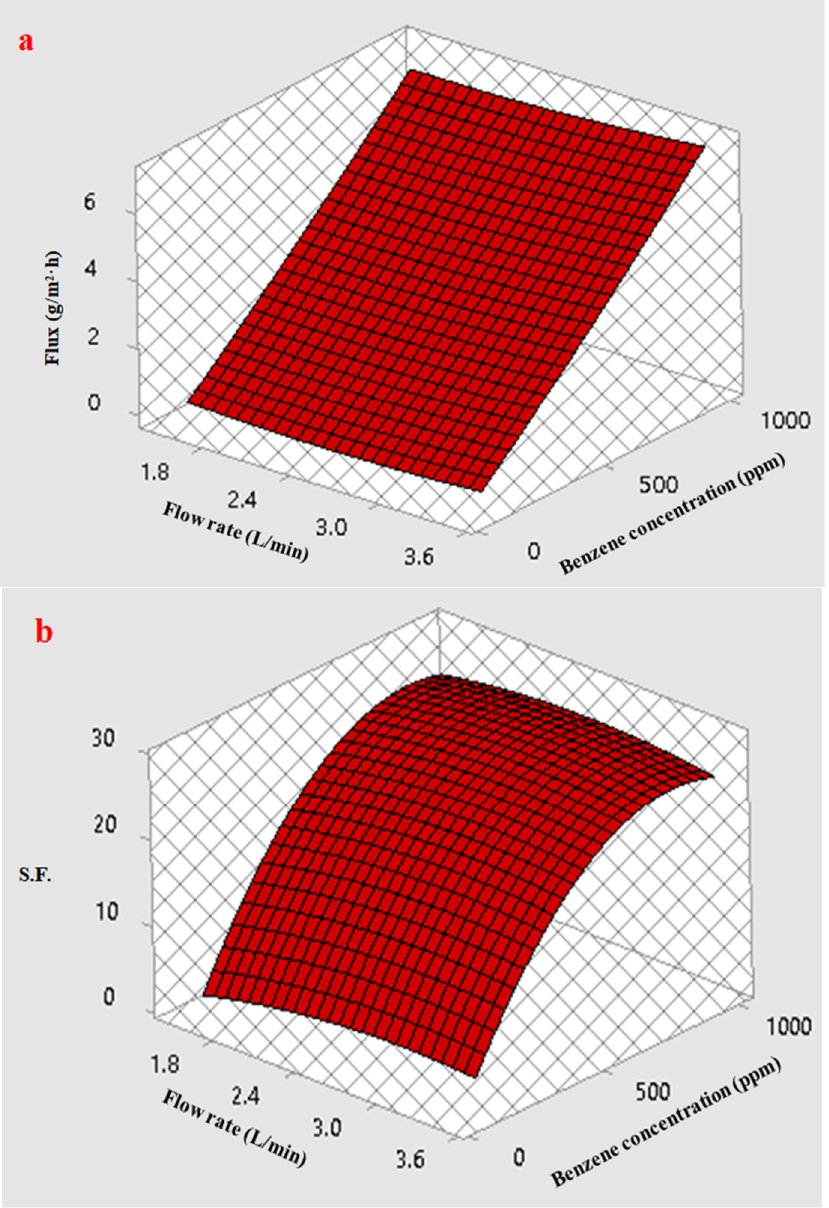
Figure 11. Effect of the feed flow and concentration on ( a ) benzene flux and ( b ) Separation factor (S.F.) at a temperature of 40 °C.